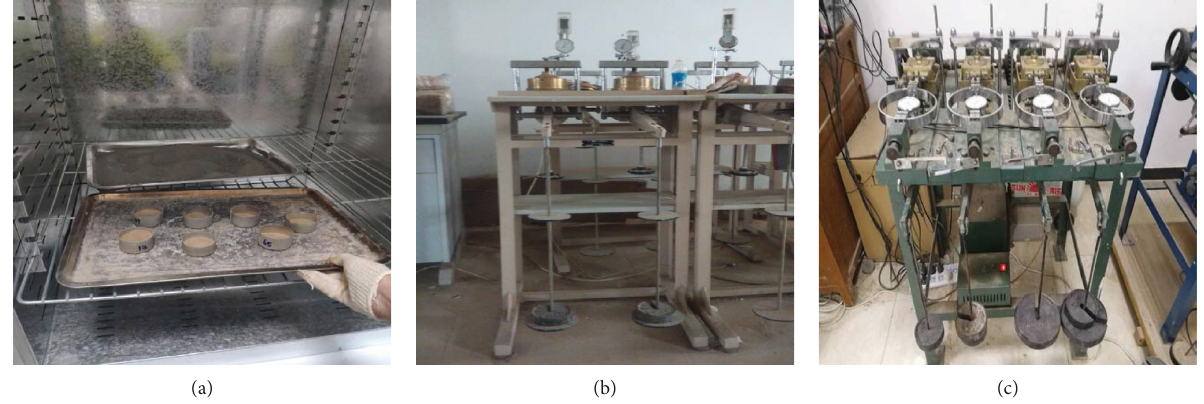
Figure 2: Indoor tests. (a) Moisture content test. (b) Compression test. (c) Direct shear test.